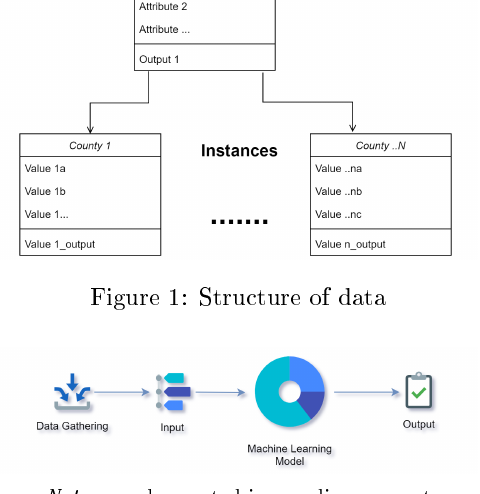
Figure 2: Flow of the